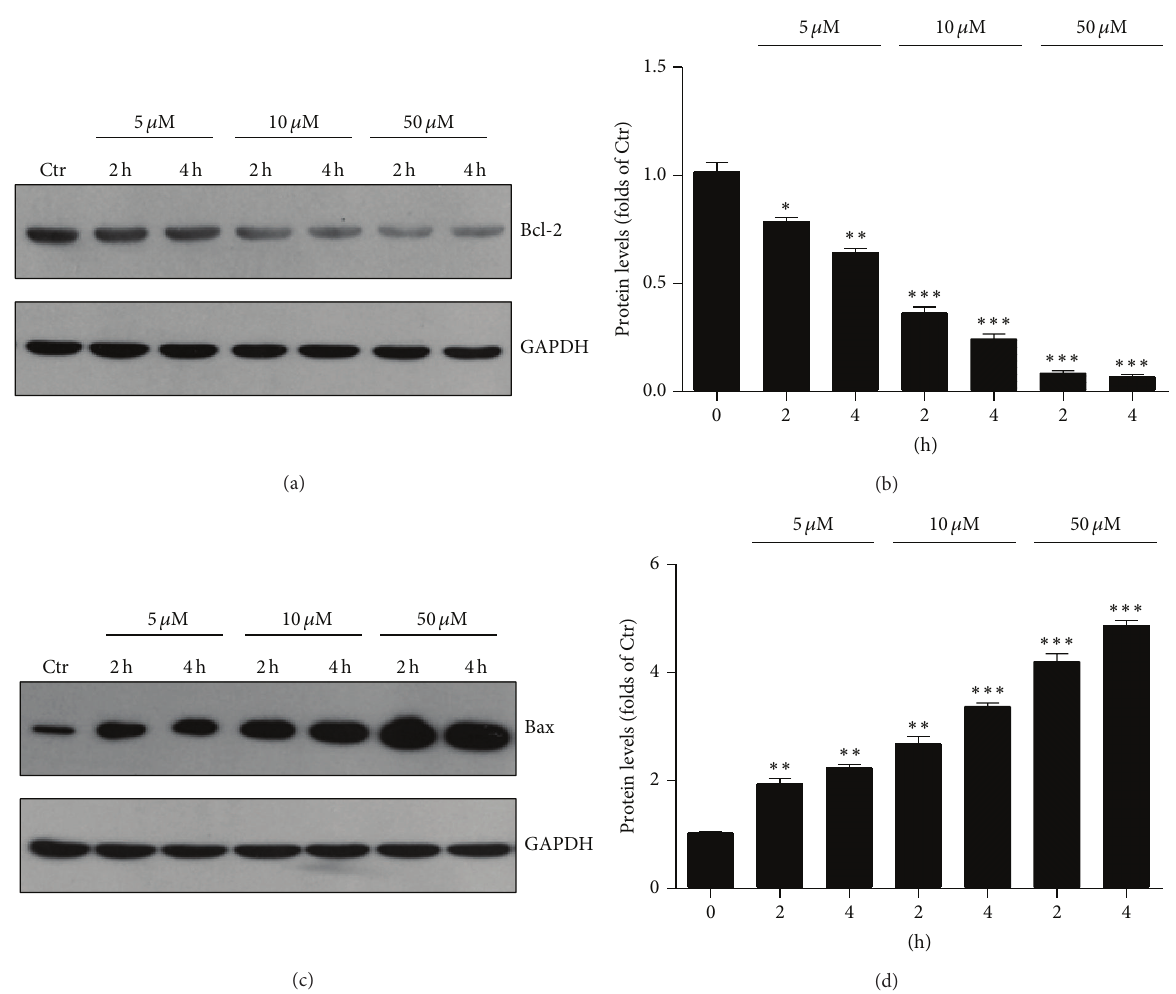
Figure 3: 4-HNE activates apoptotic signaling in MG63 cells. (a)-(b) Western blots (a) and histograms (b) showing the decreasing of protein levels of BcL-2 by 4-HNE treatment (5 to 50 𝜇 M, and 2h to 4 h) in MG63 cells. Results are averages of three independent experiments. (c)-(d) Western blots (c) and histograms (d) showing the increasing of protein levels of Bax by 4-HNE treatment (5 to 50 𝜇 M, and 2 h to 4h) in MG63 cells. Results are averages of three independent